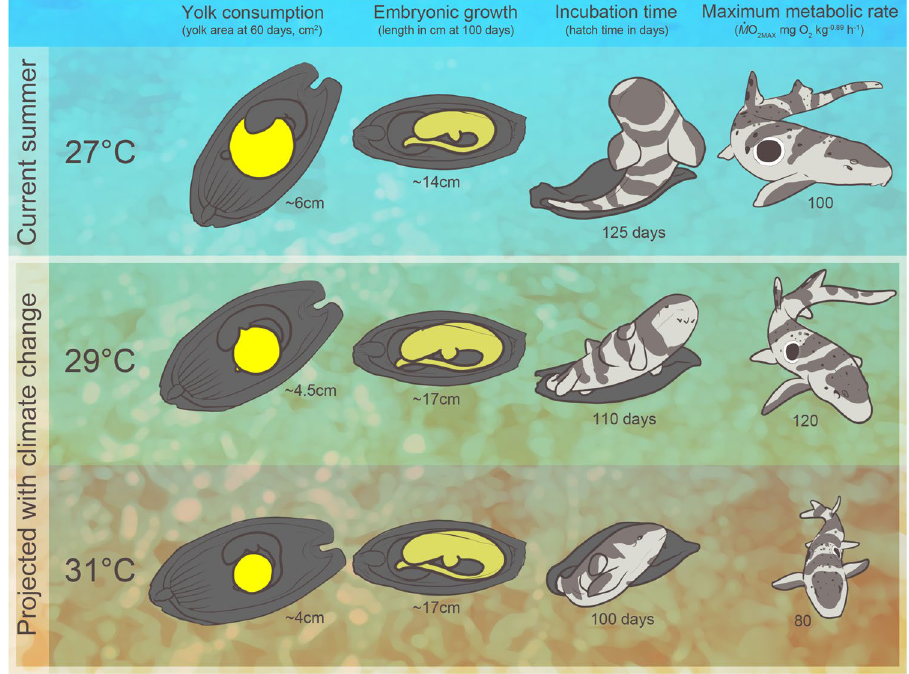
Figure 5. A conceptual diagram highlighting some of the main findings—including the yolk consumption and growth rate at mid-development, incubation time in ovo , and estimates of maximum metabolic rates at 45 days post-hatch—across current day (27 °C) and climate-change relevant (29 and 31 °C) temperature treatments. Illustration by E.